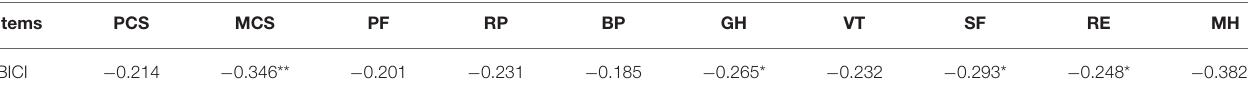
TABLE 4 | Correlation analysis of body image concern and quality of life in patients with